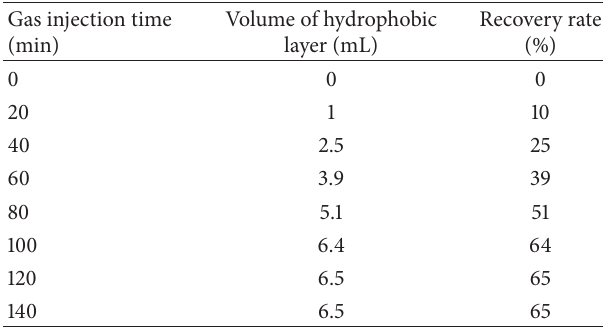
Table 4: Relationship between recovery rate of SDA and time of passing gas through when the deoiling agent switches from hydrophilicity to hydrophobicity.